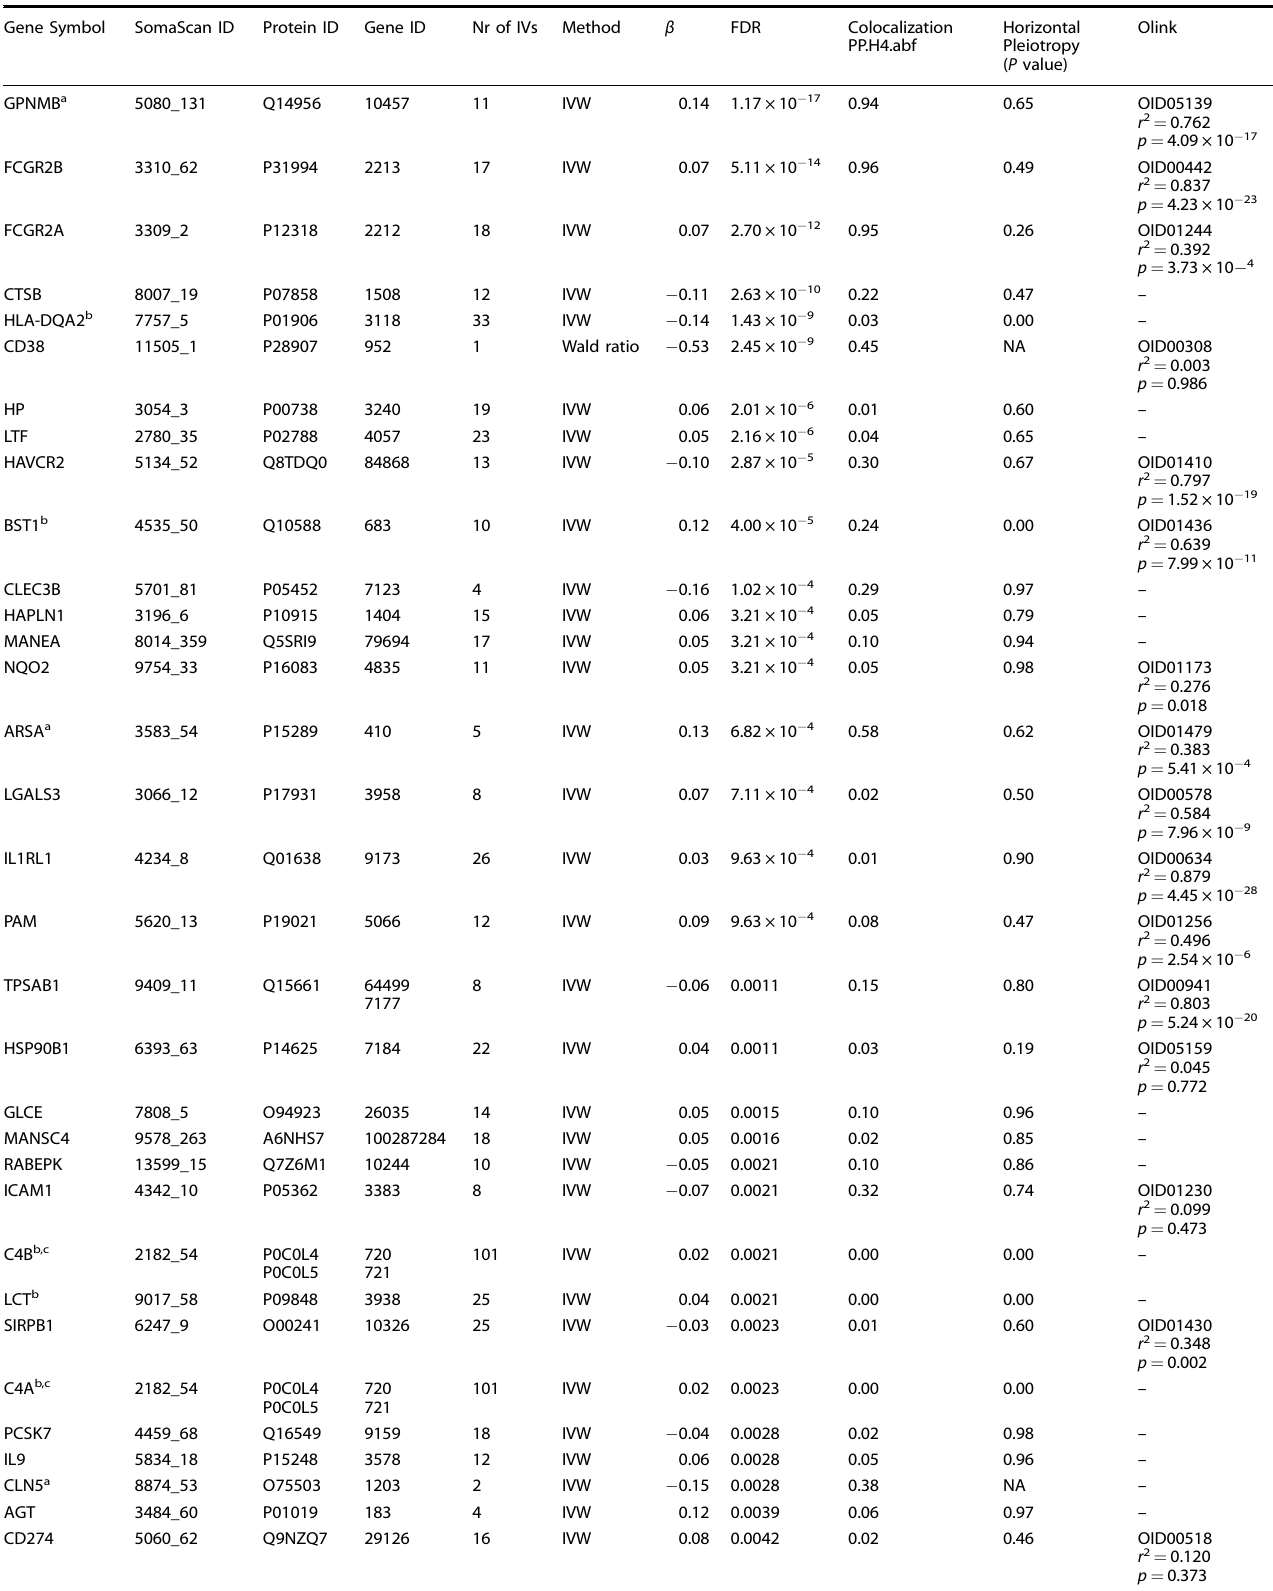
Table 2. Parkinson ’ s disease causal proteins from